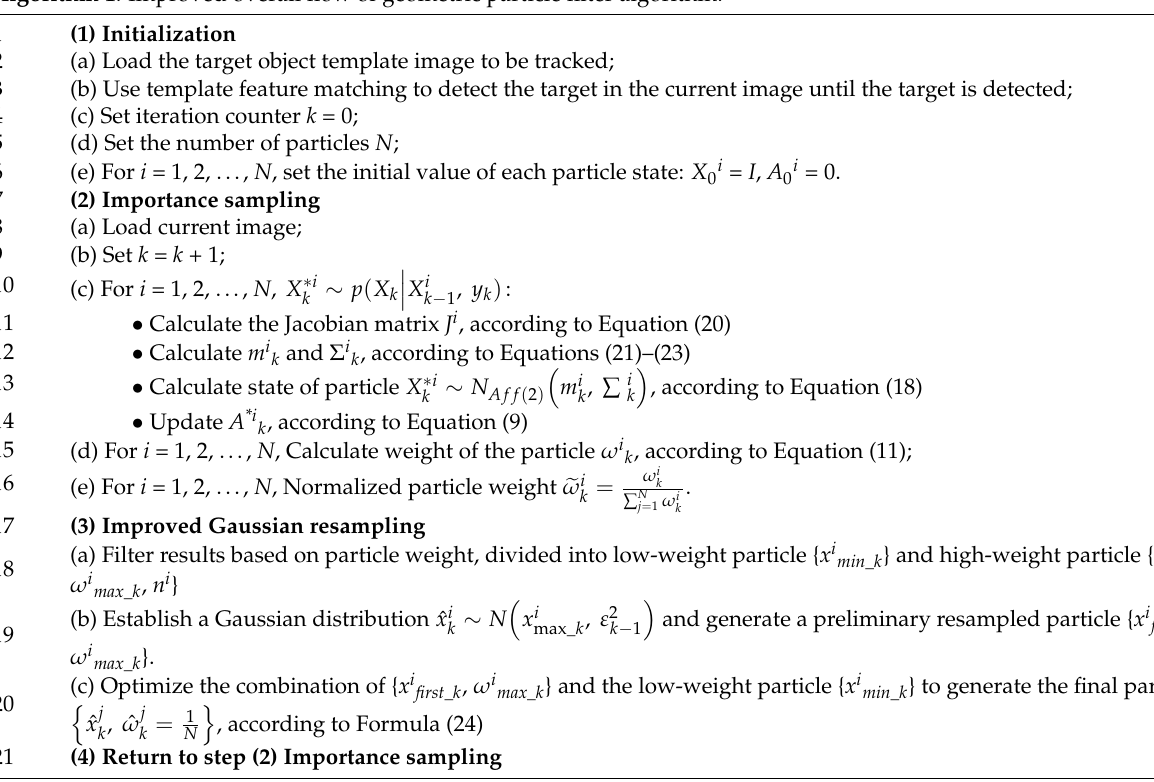
Algorithm 1 . Improved overall flow of geometric particle filter